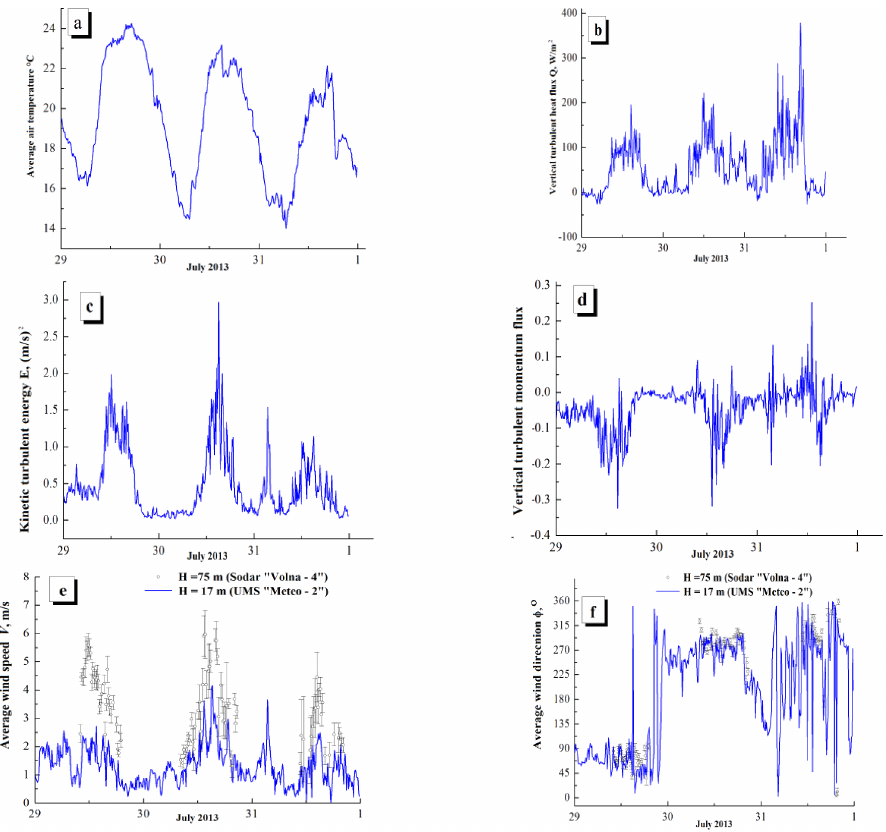
Figure 9. Time variations in the (a) air temperature, (b) vertical turbulent heat flux, (c) kinetic turbulent energy, (d) vertical turbulent momentum flux, and wind (e) speed and (f) direction at an altitude of 17m during the first cycle of measurements. The circles ( e and f ) show the wind speed and direction (with 90% confidence intervals) at an altitude of 50m.